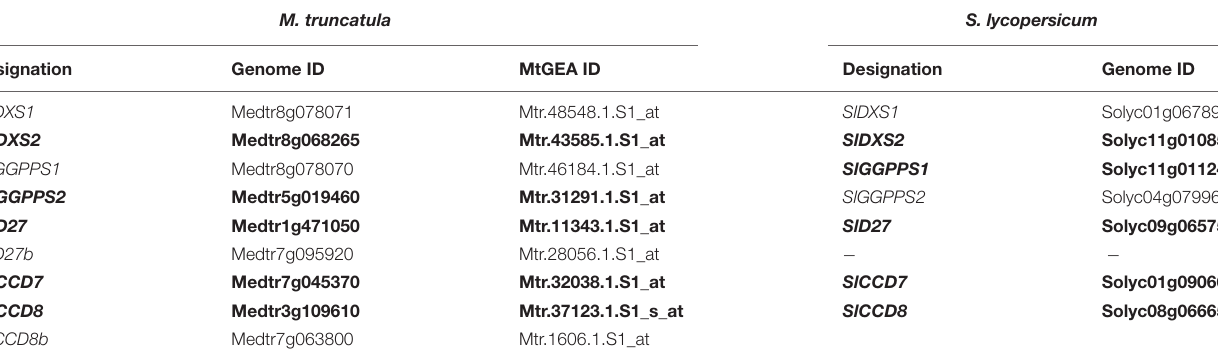
TABLE 2 | Gene families with AM-responsive isogenes in carotenogenesis and downstream carotenoid cleavage steps coregulated with PSY3 from M. truncatula ( Mt ) and S. lycopersicum ( Sl